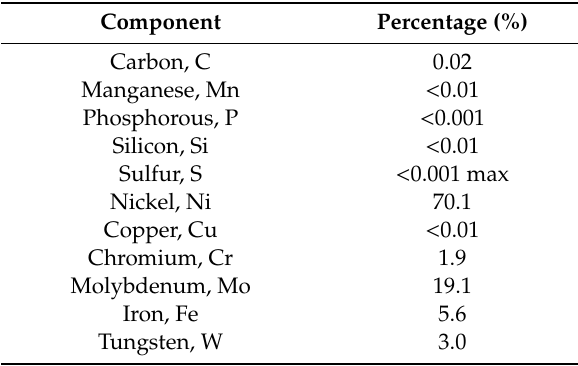
Table 1. The chemical composition of ENIMo13T0-1.